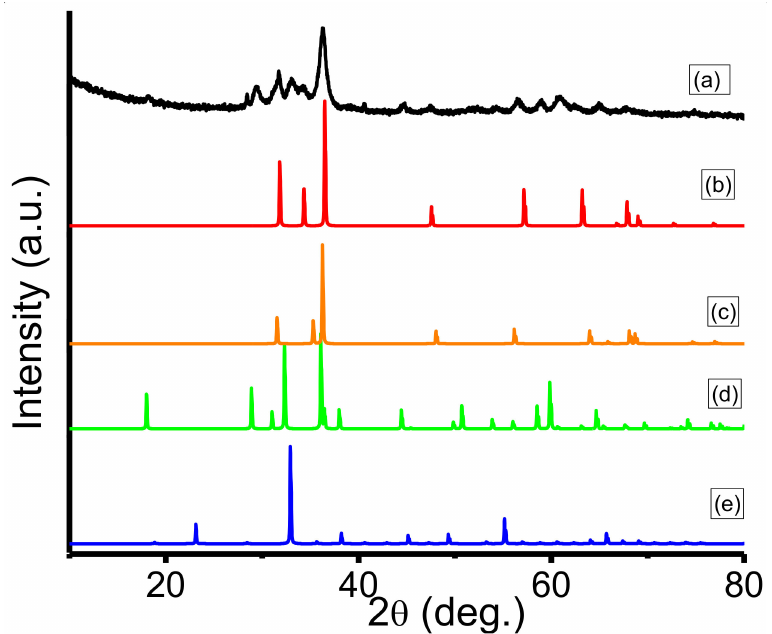
Figure 3. XRD analysis of the synthesized Mn 3 O 4 /ZnO/Eu 2 O 3 photocatalyst ( a ) and a comparative ZnO ( b ), Eu 2 O 3 ( c ), Mn 3 O 4 ( d ), Mn 2 O 3 ( e ) diffraction